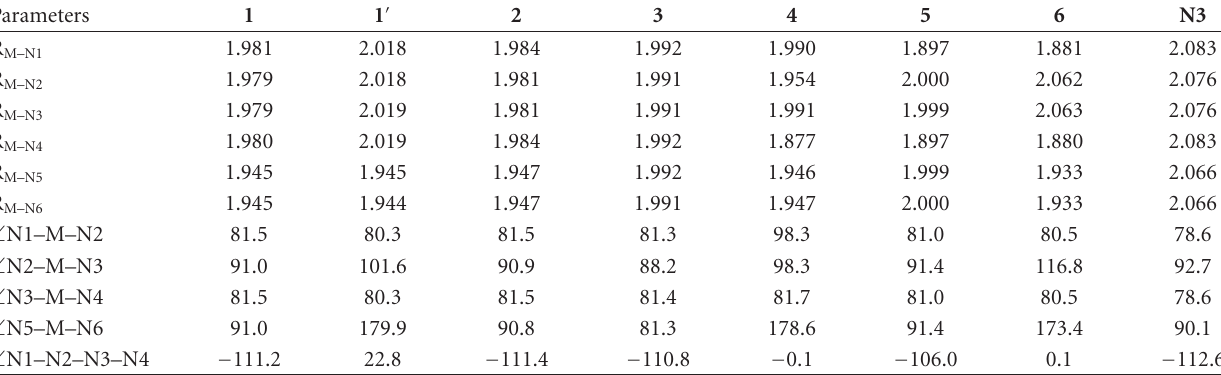
Figure 2: Optimized structures of polypyridyl Fe(II)-based complexes and N3 with the atom numbering scheme. Table 2: Selected geometrical parameters of the polypyridyl Fe(II)-based complexes calculated at the B3LYP/6-31G ∗ level in MeCN solution and N3 calculated at the B3LYP/SDD level in MeCN solution a,b